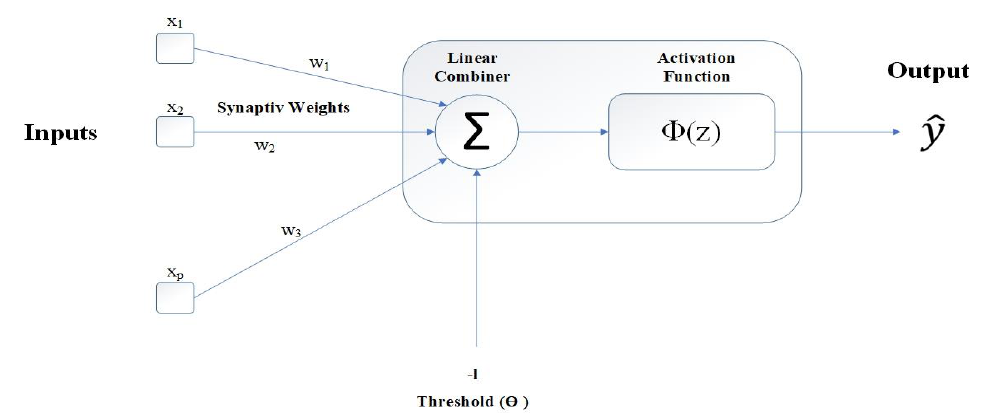
Figure 14. Schematic representation of MLP neuron.